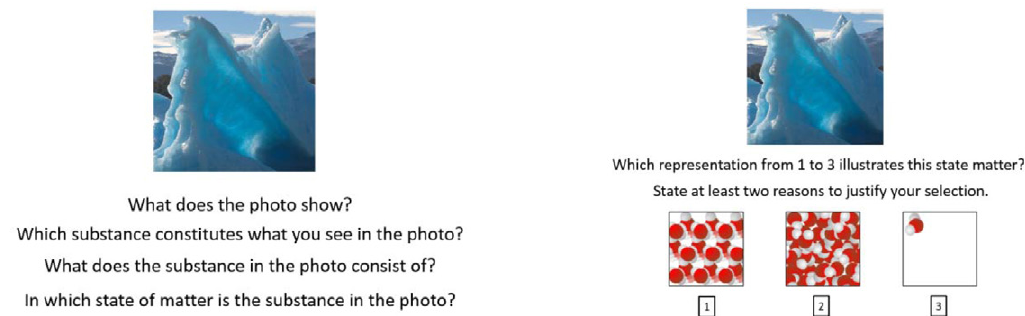
Figure 1. Screen images of the first authentic task, part 1 (left) and part 2 (right). (Image of an iceberg from hdwpics.com).